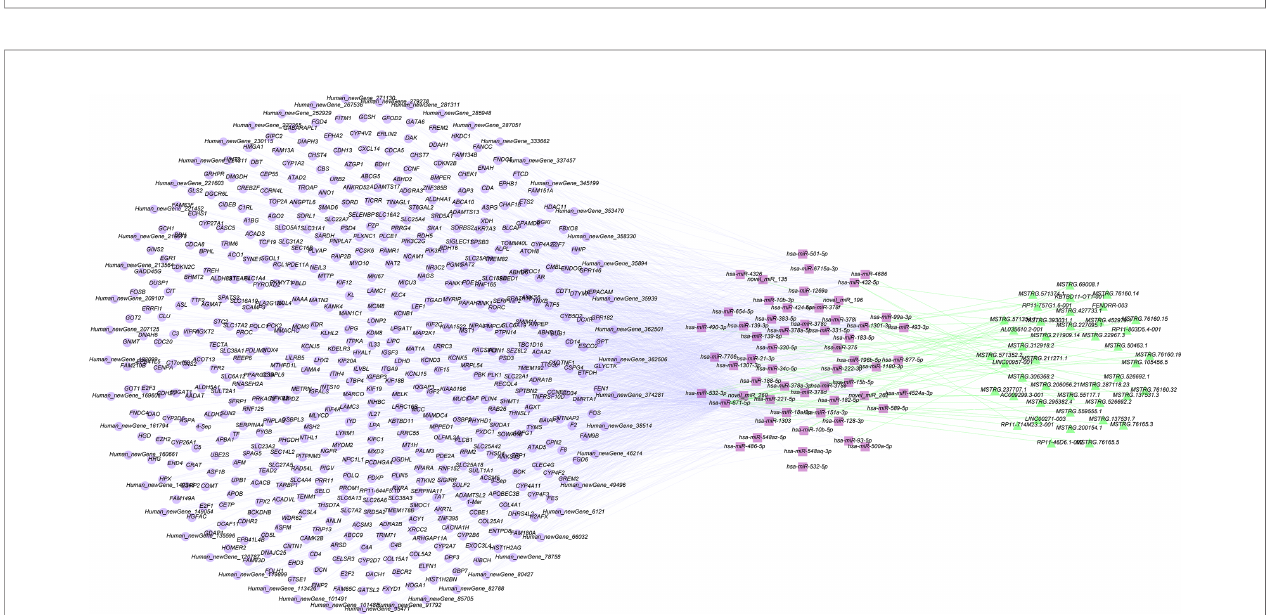
FIGURE 4 | Dif-lncRNAs 、 Dif-miRNAs GO-BP and KEGG enrichment analysis (A) Top10 GO-BP enrichment analysis of cis-lncRNAs target genes; (B) Top10 GO- BP enrichment analysis of tran-lncRNAs target genes; (C) Top10 GO-BP enrichment analysis of miRNAs target genes; (D) Top10 KEGG pathway enrichment analysis of cis-lncRNAs target genes; (E) Top10 KEGG pathway enrichment analysis of tran-lncRNAs target genes; (F) Top10 KEGG pathway enrichment analysis of miRNAs target genes.